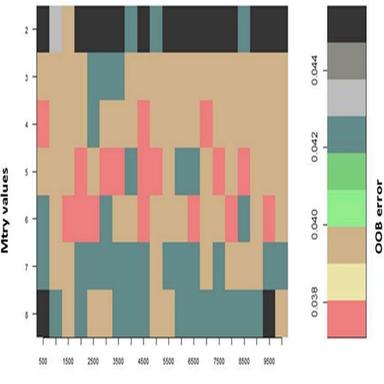
OOB errors of optimised mtry and ntree values using grid search.